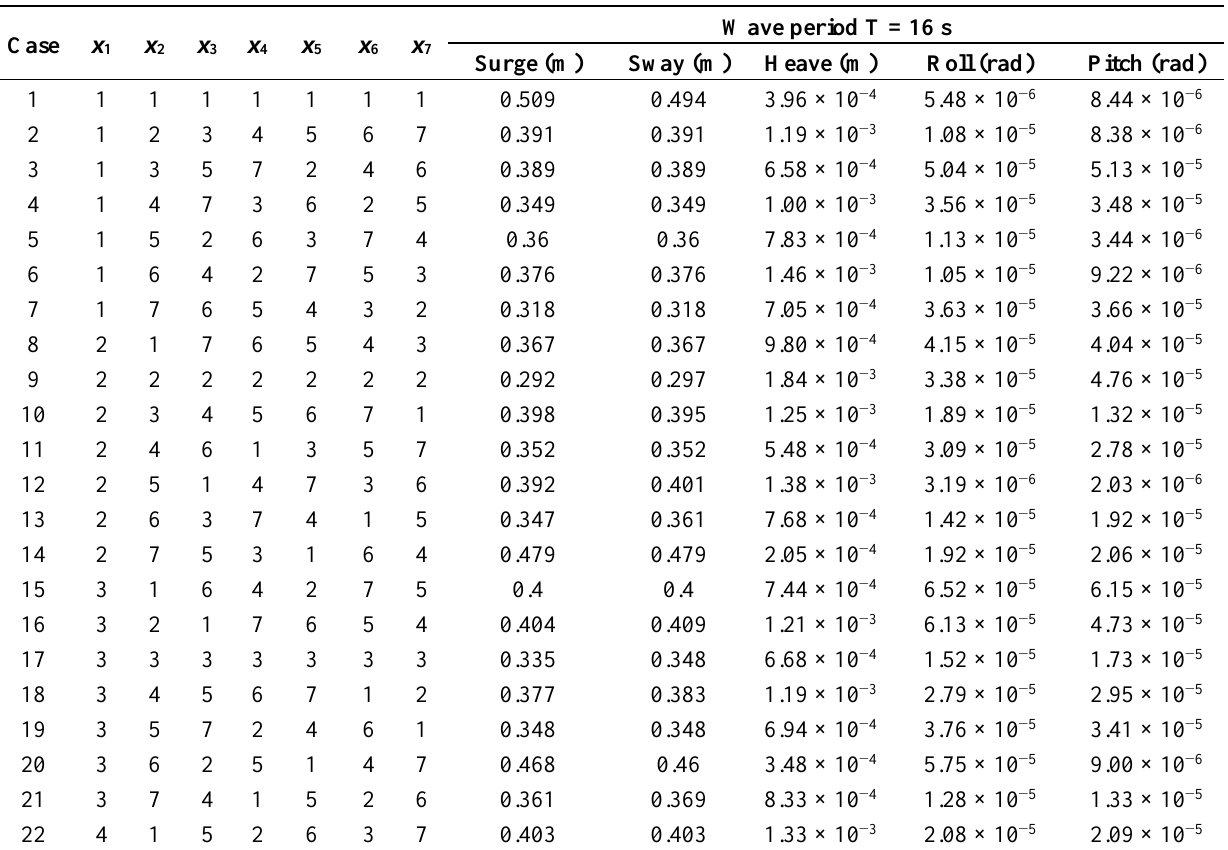
Table A2. Orthogonal table for Wave period T = 16